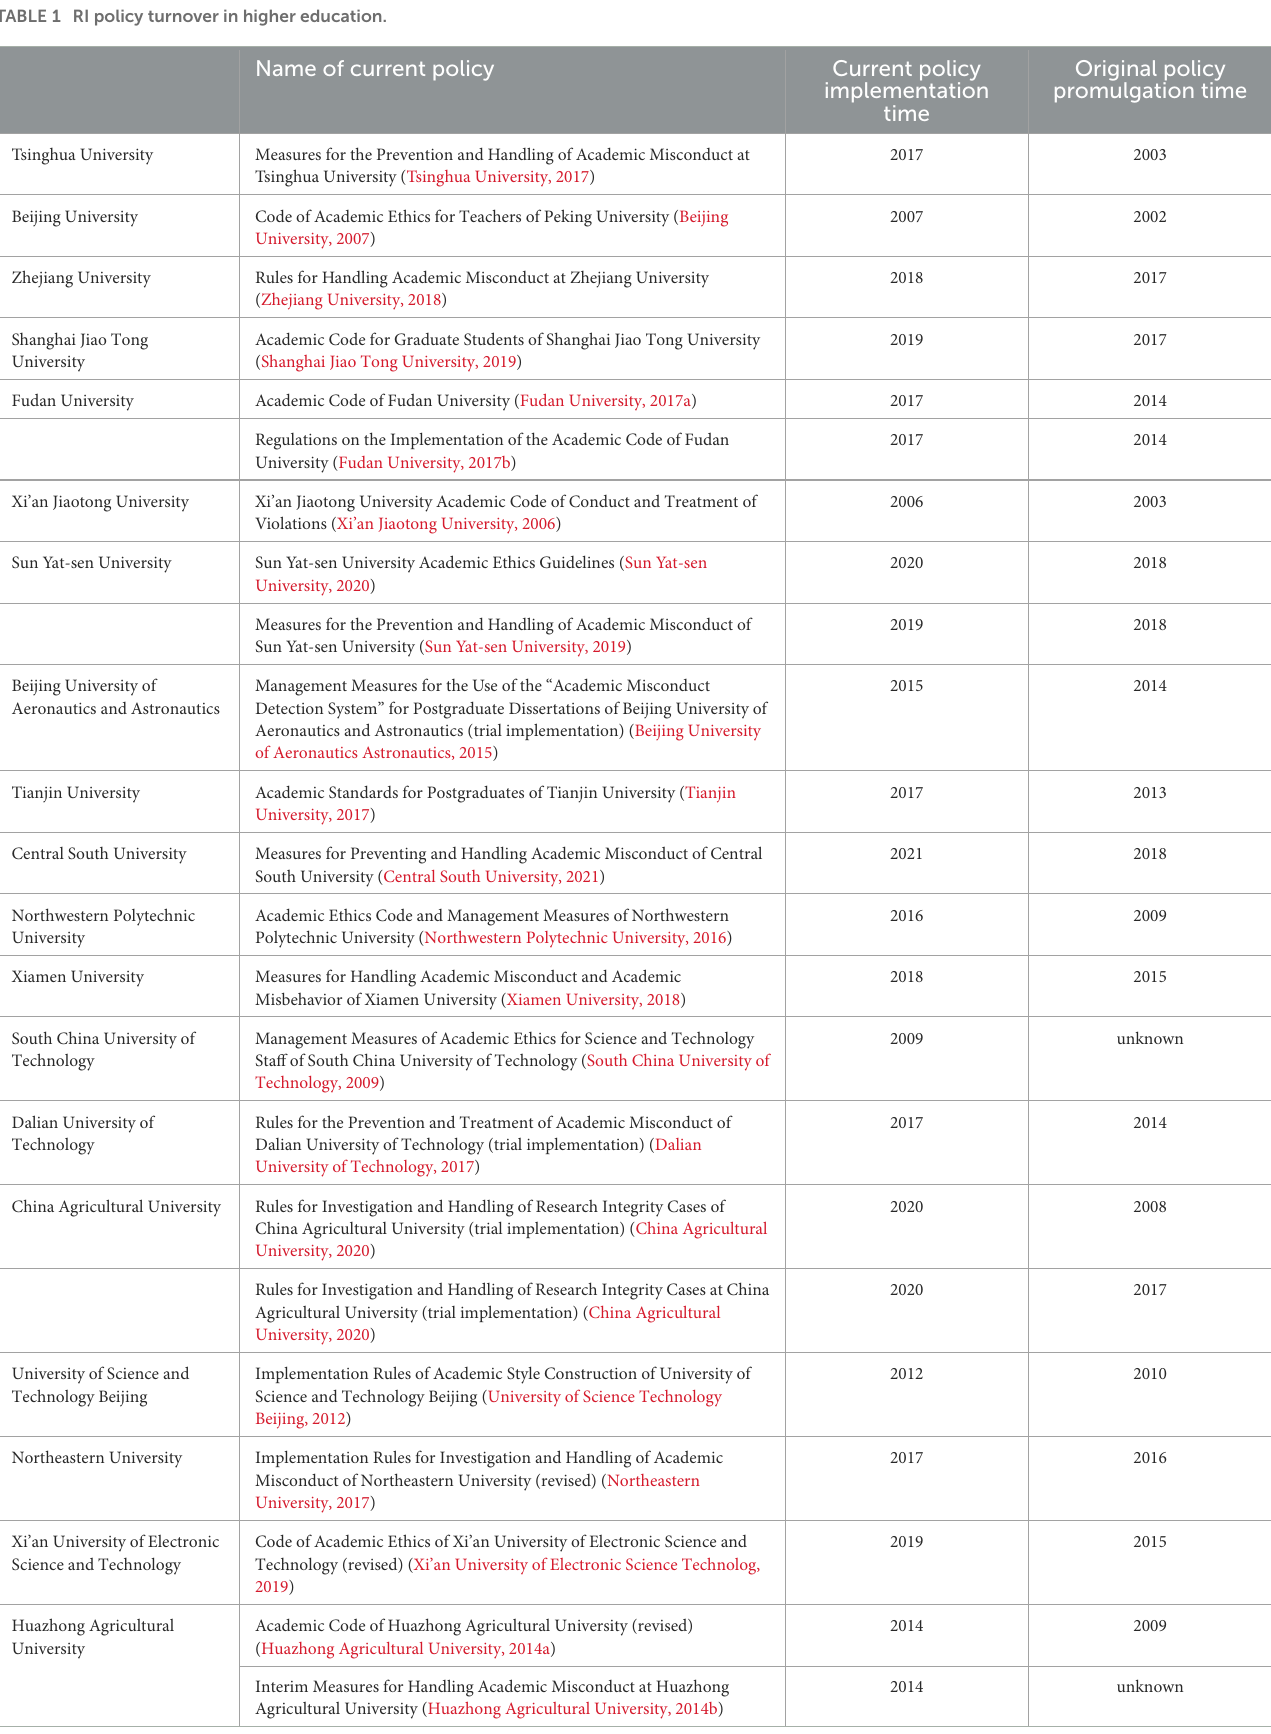
TABLE 1 RI policy turnover in higher